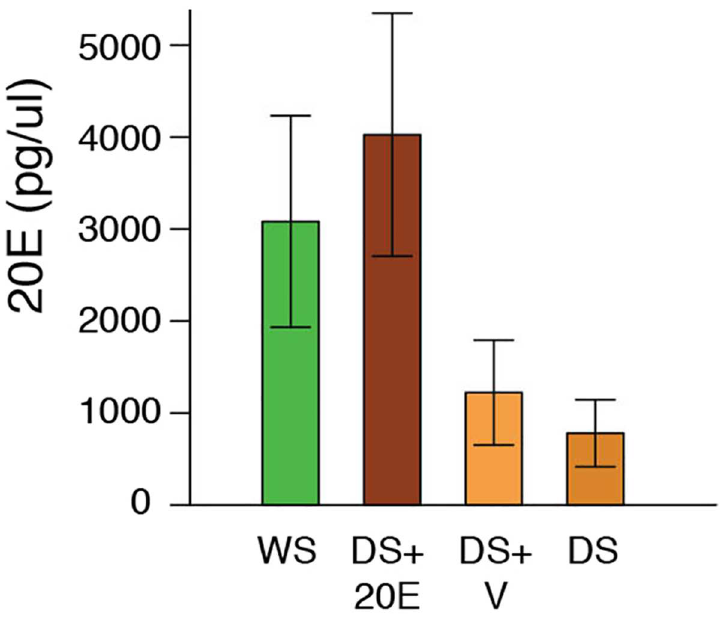
Fig 4. DS B . anynana males injected with 20E have higher titers than vehicle-injected animals. T-tests showedthat DS B . anynana males injected with 6000 pg of 20E at 50% of pupal development showed significantly higherlevels of 20E than DS males injected with vehicleat the same time. Error bars correspond to 95% confidenceintervals for the means.